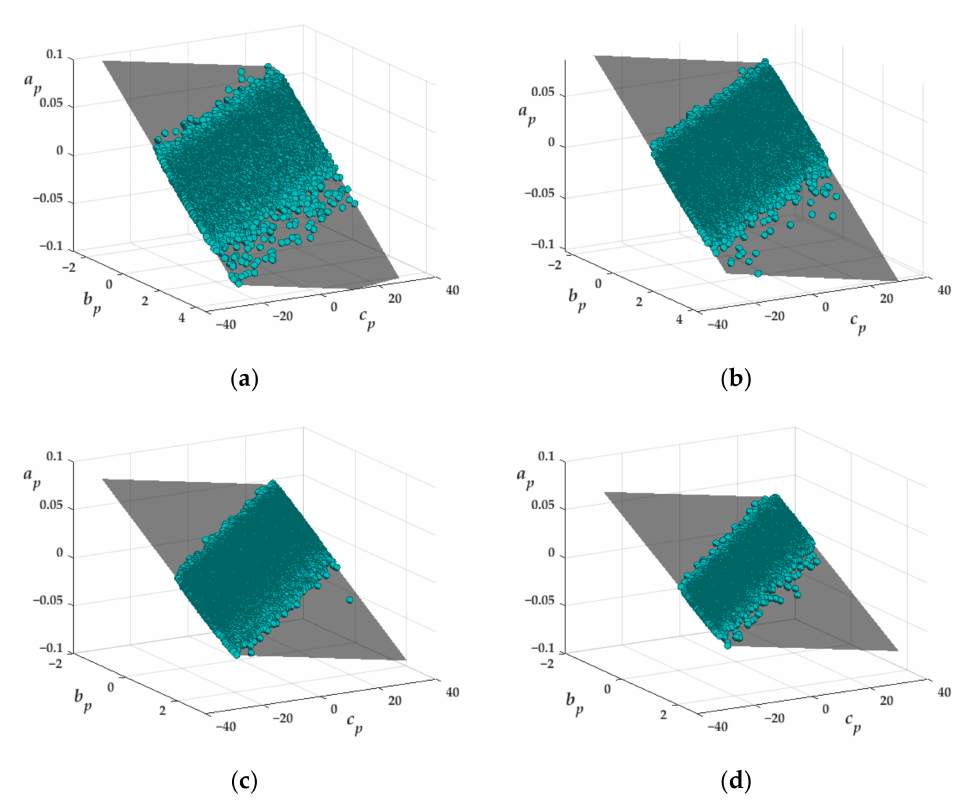
Figure 8. Relationship between the coefficients of the calibrated polynomial empirical laws a p , b p , c p : ( a ) m = 8; ( b ) m = 11; ( c ) m = 15; ( d ) m =